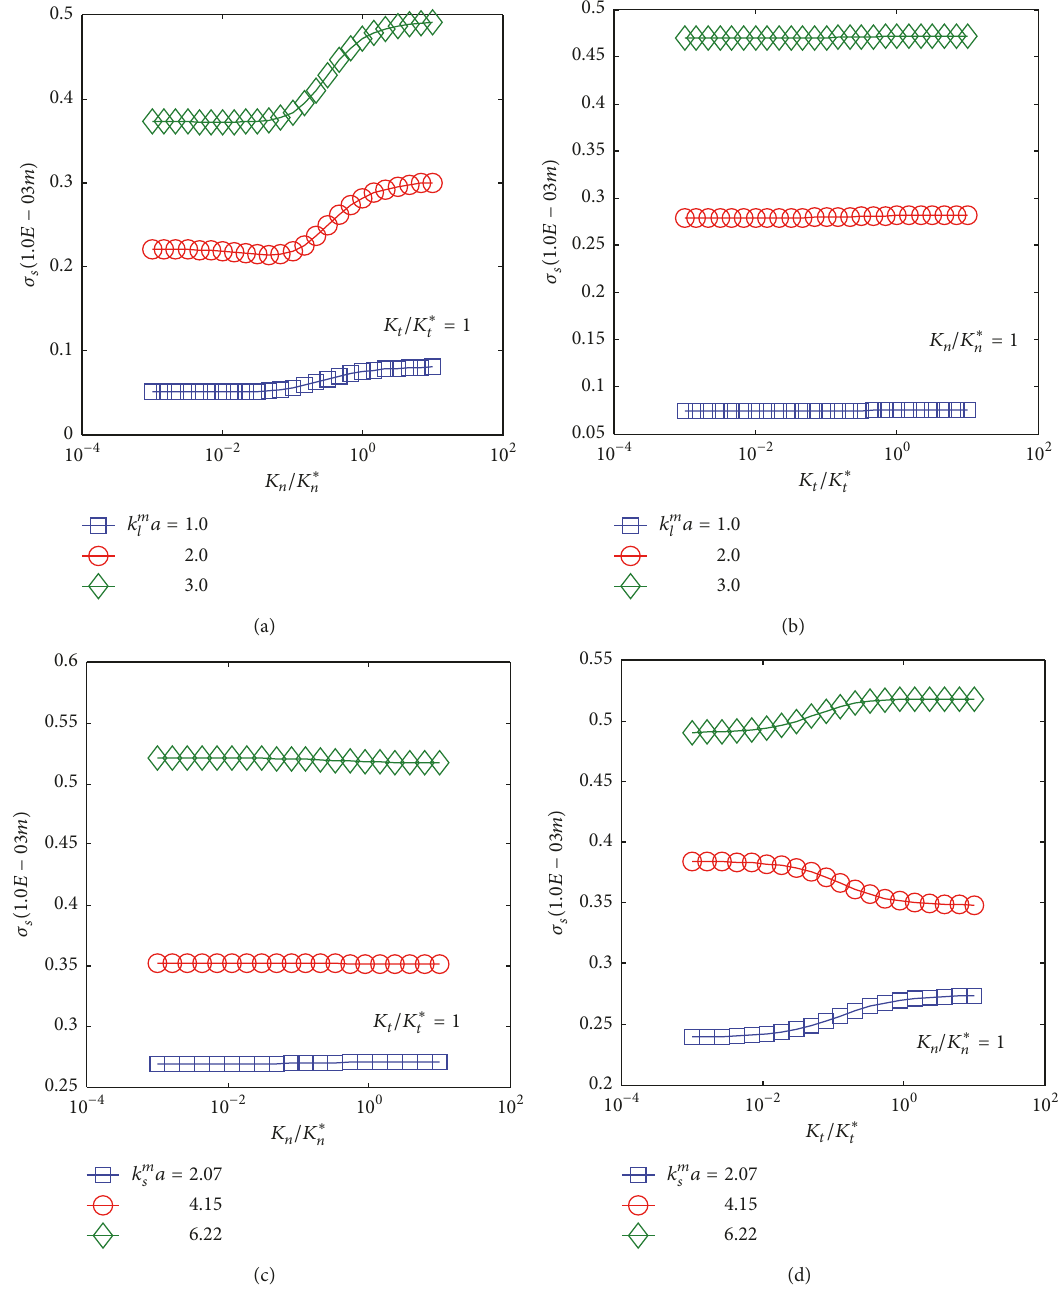
Figure 9: The influence of stiffness 𝐾 𝑛 and stiffness 𝐾 𝑡 on 𝜎 𝑠 under a P- and SV-wave incidence, respectively. (a) and (b) show results under the P-wave incidence and (c) and (d) show results under the SV-wave incidence. In (a) and (c) 𝐾 𝑡 /𝐾 ∗ 𝑡 = 1 , and in (b) and (d) 𝐾 𝑛 /𝐾 ∗ 𝑛 = 1 .